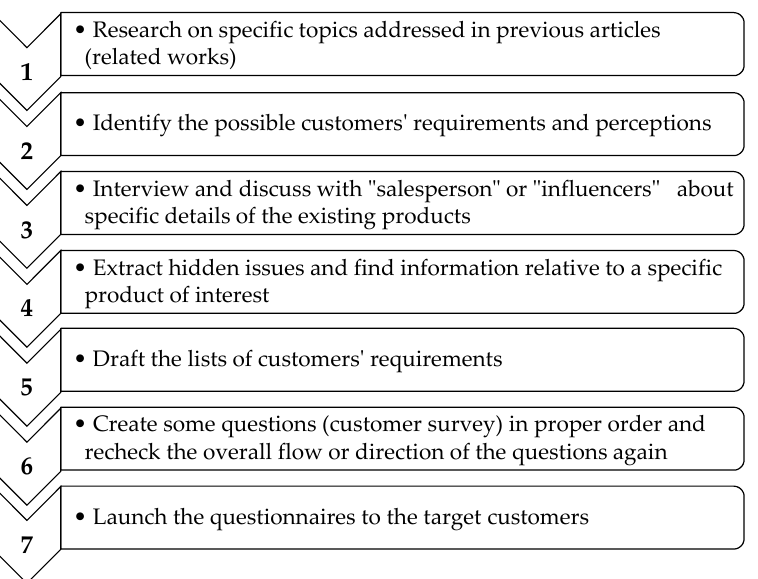
Figure 5. Steps required for creating self-administered questionnaires.